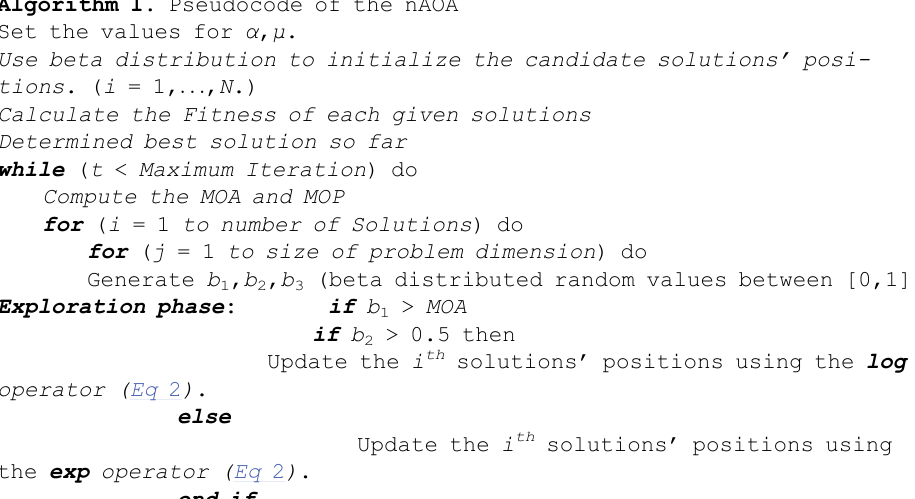
Algorithm 1 . Pseudocode of the